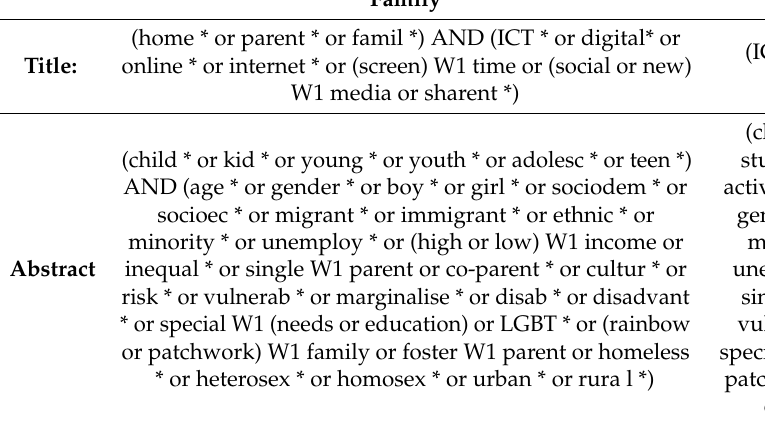
Table 2. Example of search strings: “Family” and “Civic Participation” with Boolean operators. Family Democratic